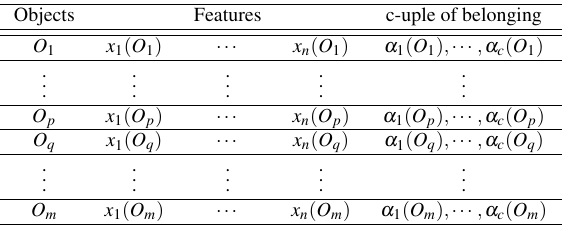
Table 1. General scheme of Training